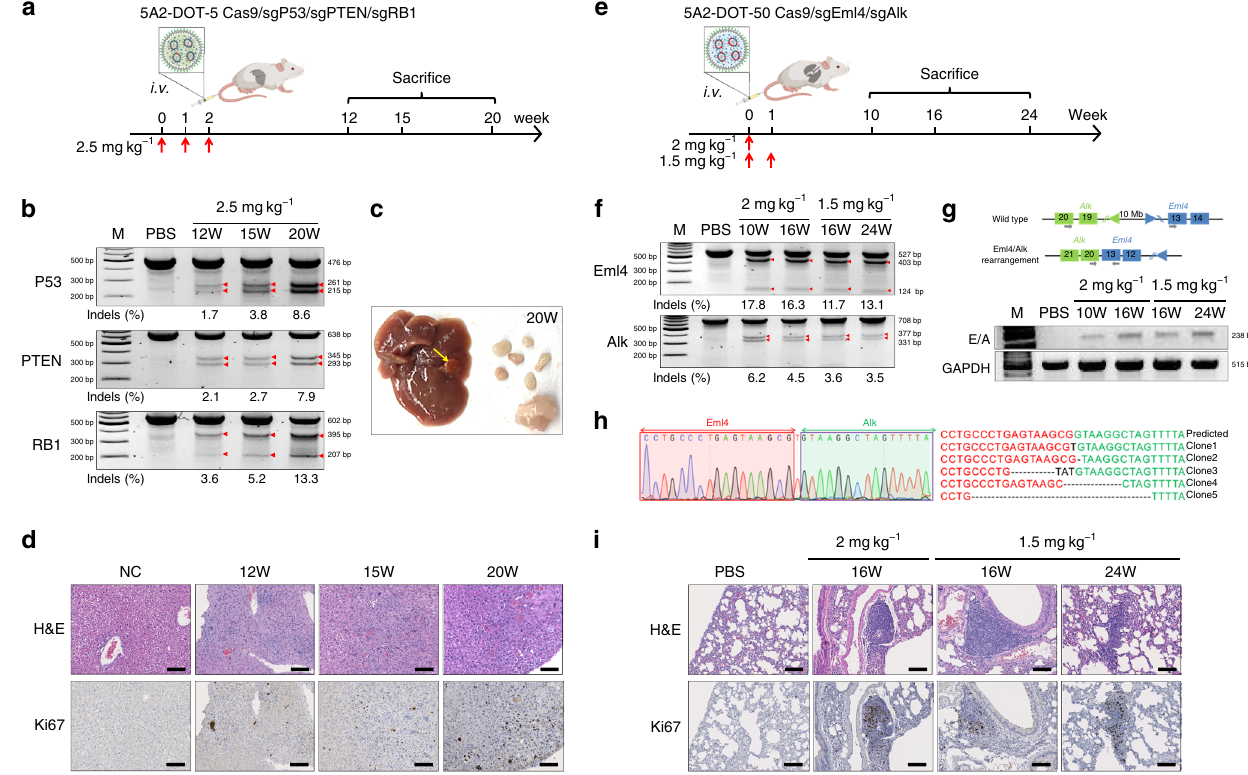
Fig. 4 5A2-DOT-X LNPs simplify generation of complex mouse models. a To create an in situ liver-speci fi c cancer model, 5A2-DOT-5 LNPs encapsulating Cas9/sgP53/sgPTEN/sgRB1 RNPs were injected into adult C57BL/6 mice weekly (three injections, 2.5 mg kg − 1 total sgRNA, IV, n = 4). After 12, 15, and 20 weeks, mice were sacri fi ced and livers were collected to analyze tumor generation. b T7EI cleavage results from genomic DNA extracted from livers con fi rmed gene editing occurred at all three loci. Red arrows indicate cleavage bands. Indel percentages shown under gel images were measured by Sanger sequencing and TIDE analysis. c Representative photograph of a mouse liver containing tumors excised 20 weeks after injection. d H&E and Ki67 staining further con fi rmed progressive tumor formation. Higher tumor proliferation biomarker Ki67 expression was detected in tumor lesions. Scale bar = 100 μ m. e To create an in situ lung-speci fi c cancer model, 5A2-DOT-50 LNPs encapsulating Cas9/sgEml4/sgAlk RNPs were injected into adult C57BL/6 mice once (2 mg kg − 1 ) or twice (1.5 mg kg − 1 weekly for 2 weeks) (IV, n = 5). After 10, 16, and 24 weeks, mice were sacri fi ced and lungs were collected to analyze tumor generation. f T7EI cleavage results from genomic DNA extracted from lungs con fi rmed gene editing occurred at loci of Eml4 and Alk . Red arrows indicate cleavage bands. Indel percentages shown under gel images were measured by Sanger sequencing and TIDE analysis. g PCR amplicons of Eml4-Alk rearrangements were also detected in all lungs treated with 5A2-DOT-50 LNPs. h Eml4-Alk rearrangements were further con fi rmed by sub-cloning and DNA sequencing. i H&E and Ki67 staining further con fi rmed progressive tumor formation. Higher tumor proliferation biomarker Ki67 expression was detected in lung tumor lesions. Scale bar = 100 μ m. Data of b , d , f , g , and i were repeated three times independently with similar